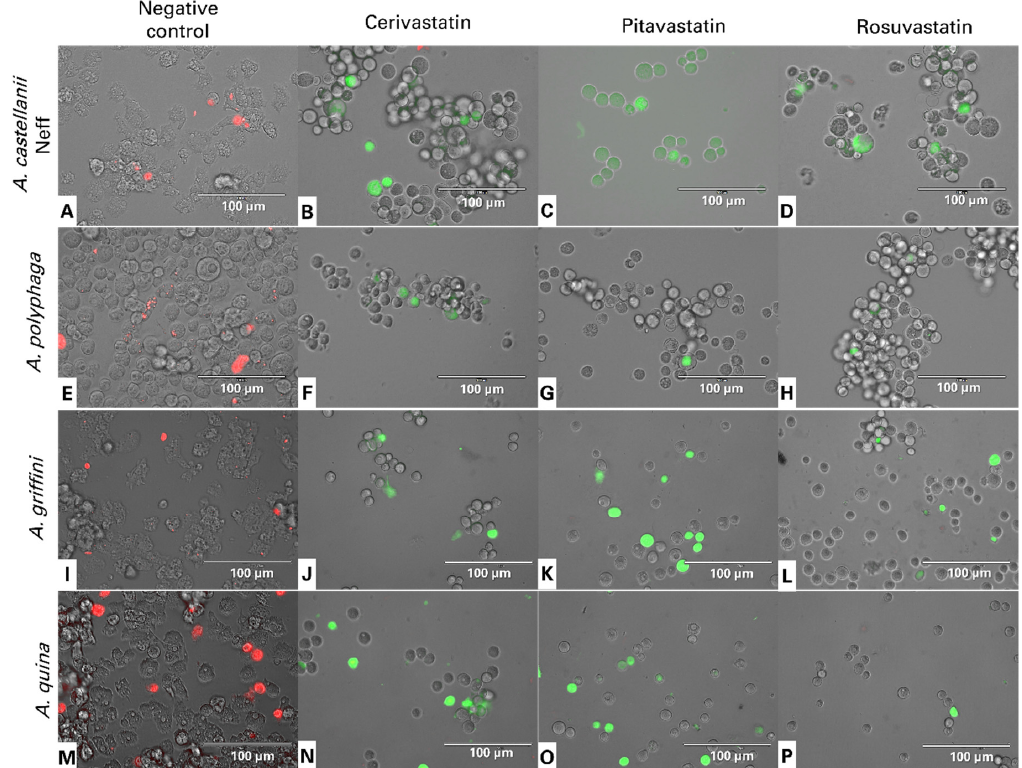
Figure 4. JC-1 dye showing the effect of IC 90 of cerivastatin ( B , F , J , N ), pitavastatin ( C , G , K , O ) and rosuvastatin ( D , H , L , P ) in trophozoites of Acanthamoeba castellanii Neff ( A – D ), A. polyphaga ( E – H ), A. griffini ( I – L ) and A. quina ( M – P ) for 24 h of incubation. JC-1 dye remained in its monomeric form inside the treated cells, emitting green fluorescence, suggesting that the statins could induce depolarization of the mitochondrial potential. In healthy trophozoites, JC-1 dye accumulated in aggregates inside the mitochondria, emitting red fluorescence ( A , E , I , M ). All images were captured using an EVOS FL Cell Imaging System EVOS™ M5000 (40× magnification). Images shown are representative of the cell populations observed in each experimental condition.